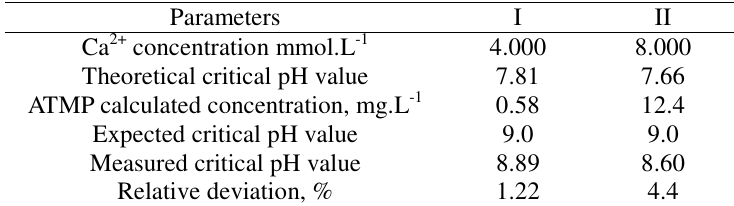
Table 2 . Measured and expected pH value in two